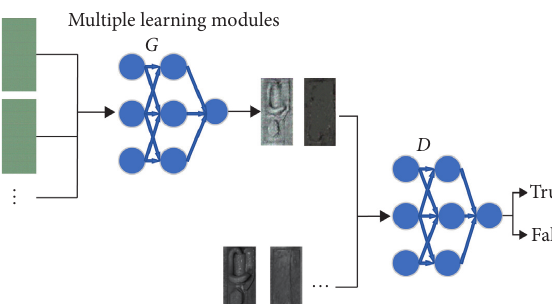
Figure 8: Generator network architecture.